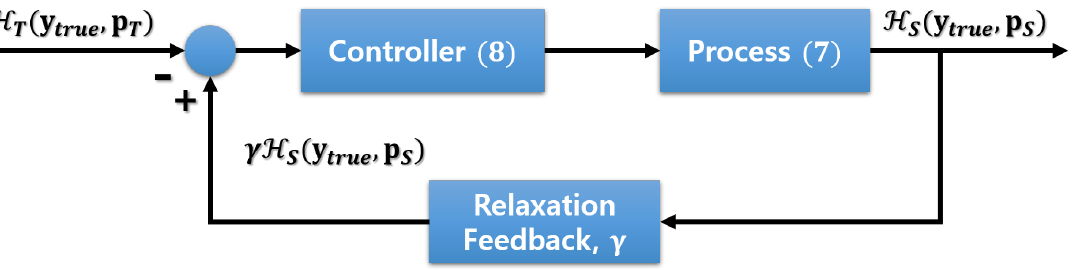
Figure 3. A graphical illustration of the feedback loop for adjusting the regularization parameter λ r